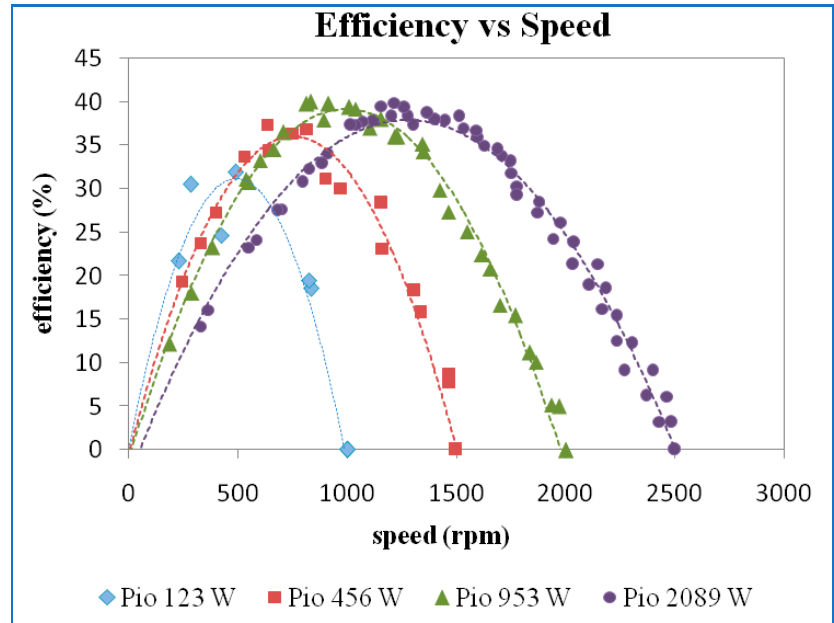
Figure 14. Efficiency vs. speed at a guide vane opening of 13 mm.